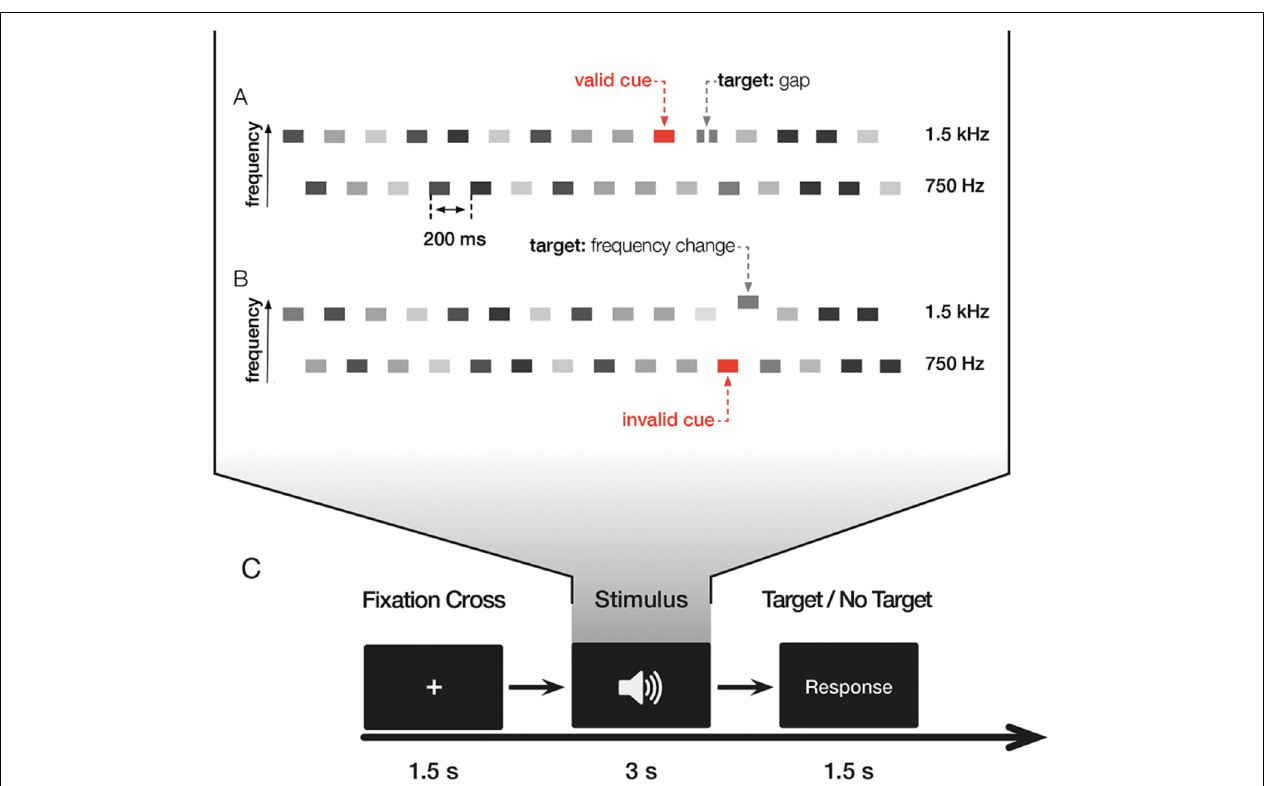
FIGURE 1 | Illustration of the experiment. The experiment consisted of two different tasks with valid trials, where the cue and the target were in the same stream, invalid trials, where the cue and the target were in different streams, and uncued trials with no cue. (A) In the gap detection task (GDT), the target was the gap; in the example shown here, the target occurs in a valid trial. (B) In the frequency change detection task (FCDT), the target was the change of the frequency; in the example shown here, the target occurs in an invalid trial. (C) Illustration of the trial. Both tasks were presented in four blocks consisting of 288 trials in total. Each trial started with a fixation cross followed by the auditory stimulus, i.e., the sequence of interleaved tone pip trains, presented binaurally via headphones. Subjects had to decide whether a target (i.e., gap in GDT and frequency change in FCDT) was present (middle finger of the right hand) or absent (index finger of the right hand) at the end of each trial by button presses. 50% of trials contained a target.